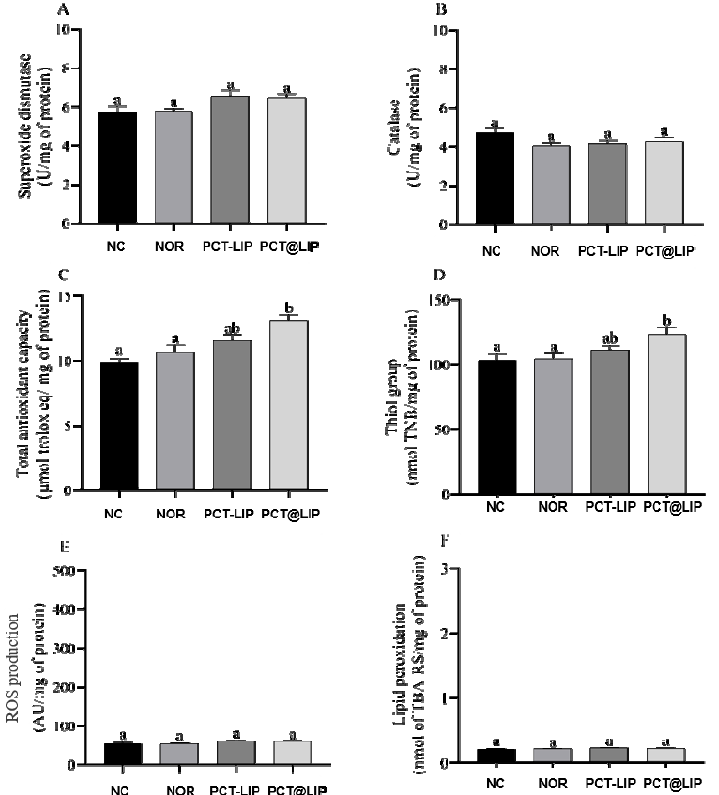
Figure 6. Levels of oxidative stress biomarkers in terms of superoxide dismutase ( A ), catalase ( B ), total antioxidant capacity ( C ), thiol groups ( D ), ROS production ( E ) and lipid peroxidation ( F ), in embryos liver chicken after treatment with norfloxacin (NOR, 20 μ g/mL) or formulations containing 20 μ g/mL NOR: PCT-LIP = liposomes encapsulating NOR and blended with pectin solution and PCT@LIP = hybrid liposomal-pectin formulation containing NOR. NC = negative control; n = 10. Data expressed as mean ± SEM. Statistical tests: One-way ANOVA/Tukey ( p < 0.05).